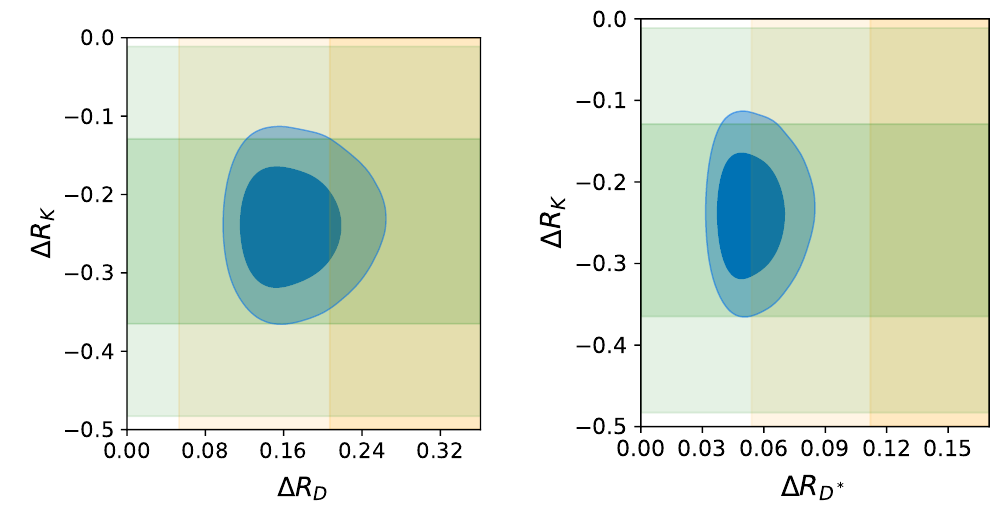
Figure 6 . 68% (dark blue) and 95% (light blue) posterior probabilities of the NP shifts in R D (cid:3) vs. (cid:1) R K . The experimental values at 1 (cid:27) (2 (cid:27) ) are indicated by the dark (light) coloured bands. parameters ( (cid:15) , s , and (cid:15) e ) turn out to have magnitudes in good agreement with their (cid:28) U R natural parametric